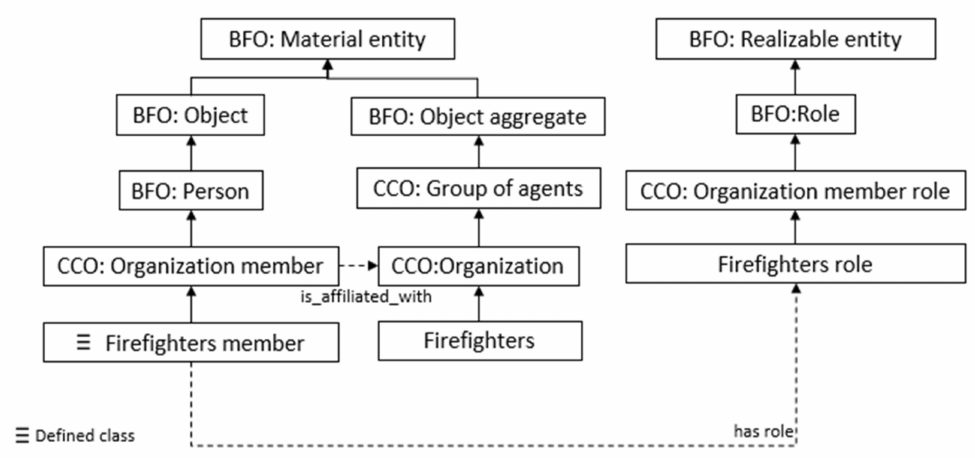
Figure 11. Definition of ER roles in POLARISCO.